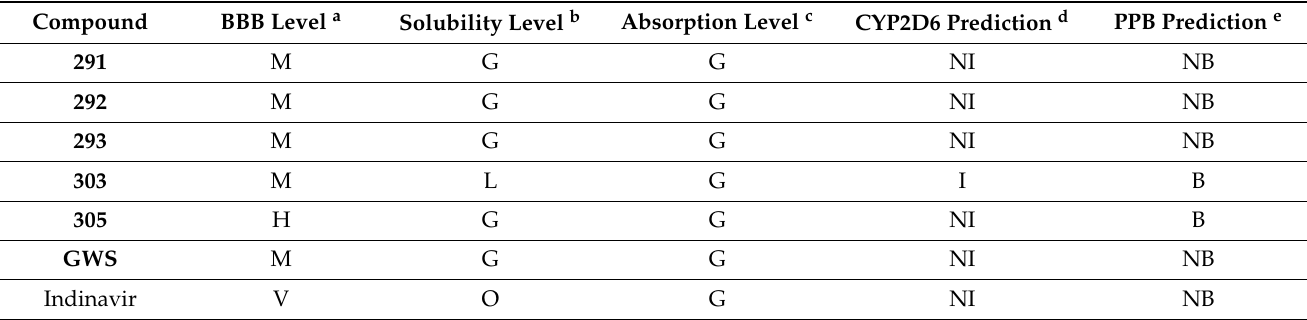
Table 3. Predicted ADMET for the designed metabolites and reference drug.